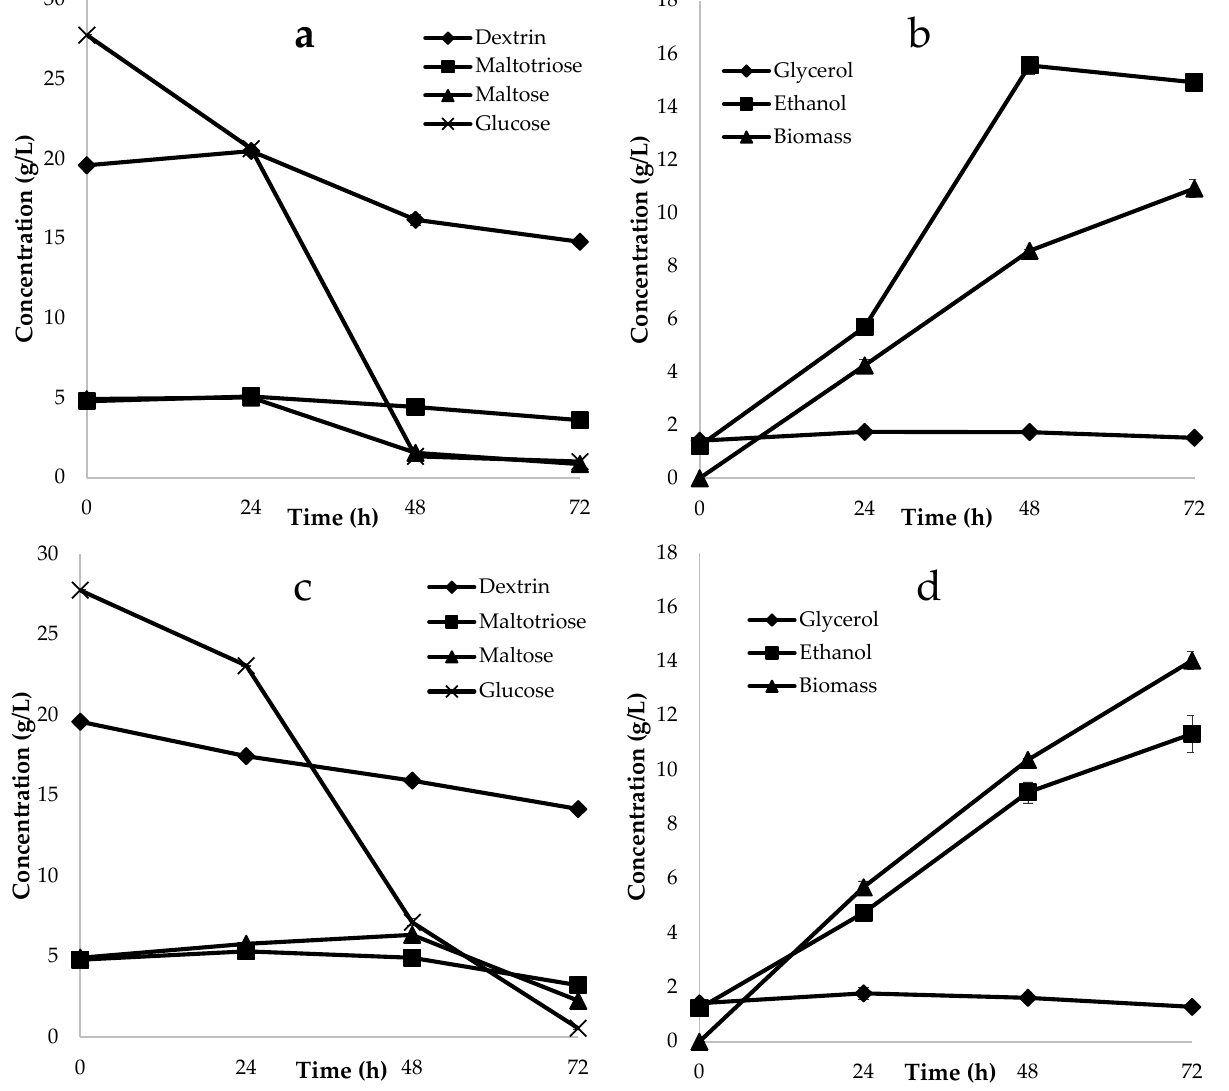
Figure 2. Concentration profiles of ( a , c ) sugars and fermentation products ( b , d ) during cultivation of N. intermedia ( a , b ) and A. oryzae ( c , d ) using the stillage obtained after the first fungal fermentation on bread waste hydrolysate. Results are average values ± one standard deviation ( n = 2).